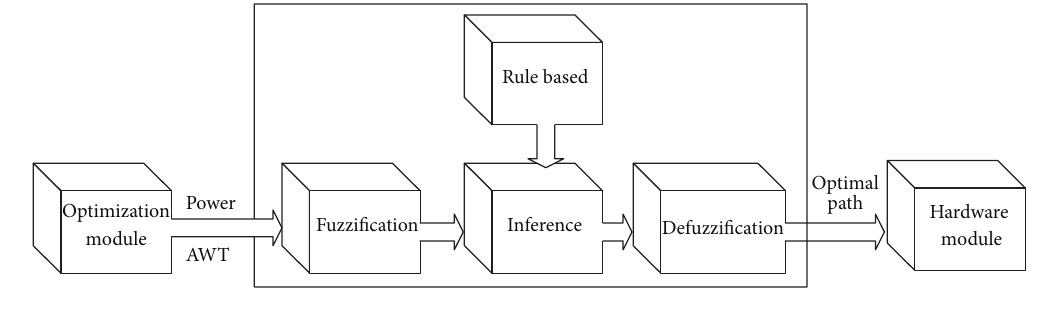
Figure 4: Fuzzy logic module.